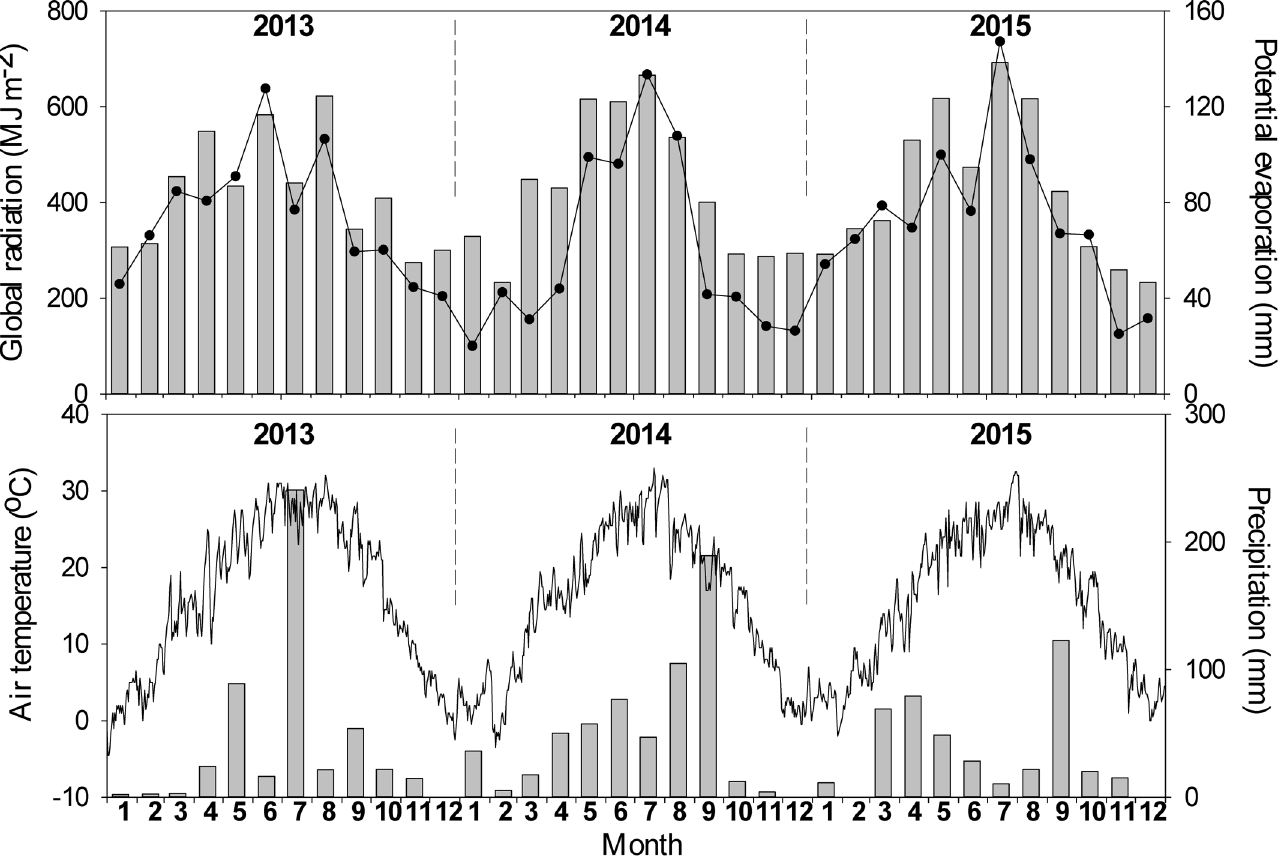
Fig 2. Monthly global radiation, potential evaporation, precipitation and mean daily air temperature of 2013, 2014 and 2015. Bars denote the monthly globalradiationand precipitation, respectively.Lines represent the monthly potential evaporationand mean daily air temperature, respectively.